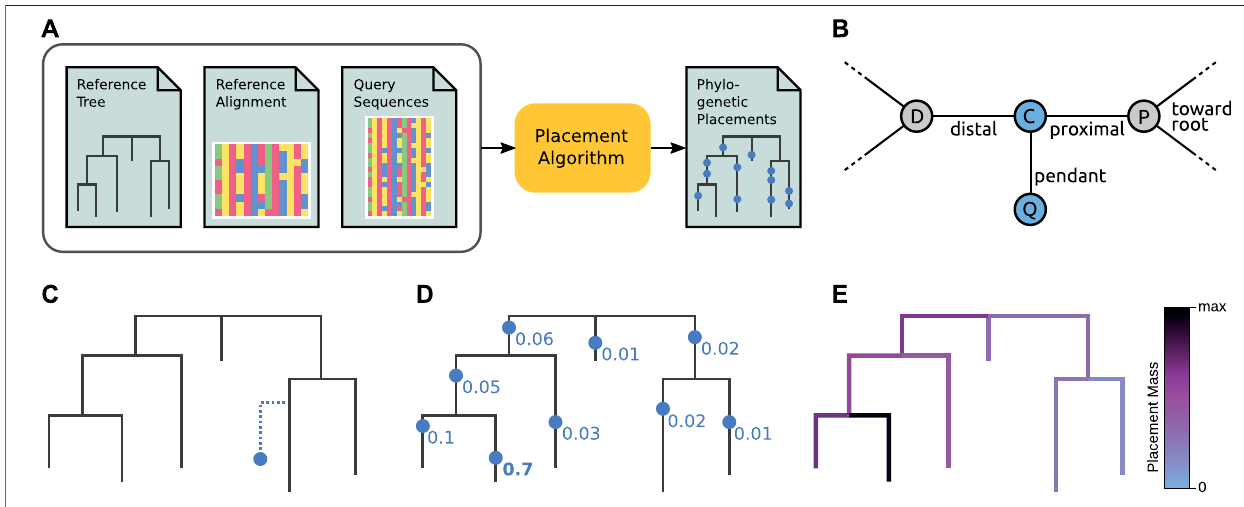
FIGURE 2 | Overview of phylogenetic placement. Here, we show the typical process, focused on ML-based placement. For the sake of simplicity, we here omit heuristics and other algorithmic improvements. Alignment-free placement works conceptually in an analogous way, but does not compute tree likelihoods. (A) Pipeline and data fl ow. The input tophylogenetic placement arethe Reference Tree (RT) and its correspondingReference Alignment (RA), aswell asthe set ofQuery Sequences (QSs) that we are interested in. The placement algorithm computes potential placement locations of a QS on the branches of the RT, for each QS in the input. (B) Terminology.ThenodesDandPbelongtotheReferenceTree(RT).WhenplacingaQuerySequence(QS),thebranchbetweenthesenodesissplitintotwopartsby a temporary new node C, which serves as the attachment point for another temporary new node Q that represents the QS. Note that these two new nodes are only conceptually inserted into the RT – they represent the mapping of the QS onto that branch. The pendant branch leads to Q. The original branch is split into the proximal branch, which leads towards the (possibly virtual) root of the RT, and the distal branch, which leads away from the root. (C) A single QS is placed onto a single branch (that is, one placement location). Vertical distances symbolize branch lengths. Note that the QS is located at a certain position along its Reference Tree branch (splitting thatbranchintodistalandproximalparts),andhasa(pendant)branchlengthofitsown.Atthisstep,ML-basedplacementcomputesthelikelihoodoftheRTwiththeQS asa(temporary)extrabranch.ForonesingleQS,thisstepisthenrepeatedateverybranchofthetree. (D) OncethelikelihoodsofplacingtheQSontoeverybranchhave been computed, the Likelihood Weight Ratios (LWRs) for this QS are computed. They express the con fi dence of placing the QS onto each branch, and can be interpretedasaprobabilitydistributionoftheQSacrossthetree(andhencesumtooneacrossallbranches).Intheimage,weomitpendantbranchlengthsforthesakeof simplicity. (E) The process is repeated for every QS, yielding an LWR-weighted “ mapping ” of each QS to each branch. We can visualize this as a cumulative distribution across all QSs on the tree, coloring branches according to the total sum of the LWRs at that branch over all QS. See Figure 4A for a real-world example of